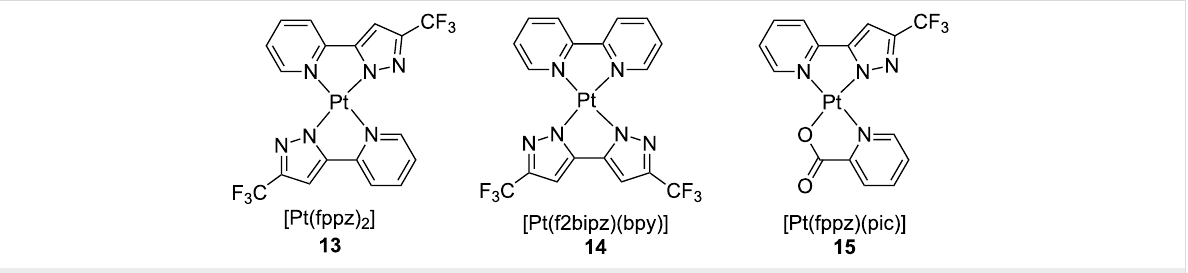
Figure 7: Neutral platinum(II) complexes 13 – 15 bearing azolate ligands [13].